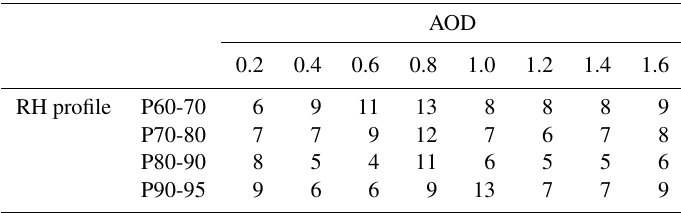
Figure 6. Retrieved σ ext profiles from field measurements from MPL signals at (a) 13:00 and (b) 14:30LT on 5 July 2016. The dashed line represents the retrieved σ ext profiles using the constant LR profile method. The solid line represents the retrieved σ ext profiles using the variable LR profile method. Table 1. Relative difference (%) between the σ ext profiles by using the proposed new method and the parameterized σ ext profiles under different AOD and RH profile